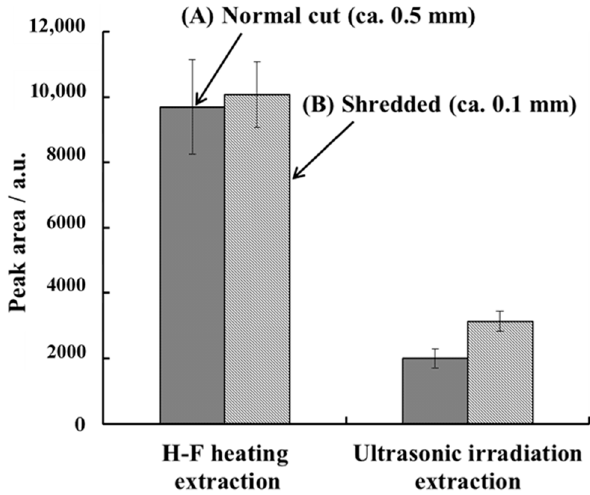
Figure 5. Effect of the size of pieces in the sample (((A) fill pattern = dots) cut to 0.5 mm, ((B) fill pattern = diagonal lines) shredded to 0.1 mm) on the caffeine peak area after H-F heating extraction and ultrasonic irradiation extraction. The sample mass was 10 mg and the extraction solution volume were 200 µ L. The other parameters were the same as in Figure 4. Error bars represent the standard deviation ( n = 3).